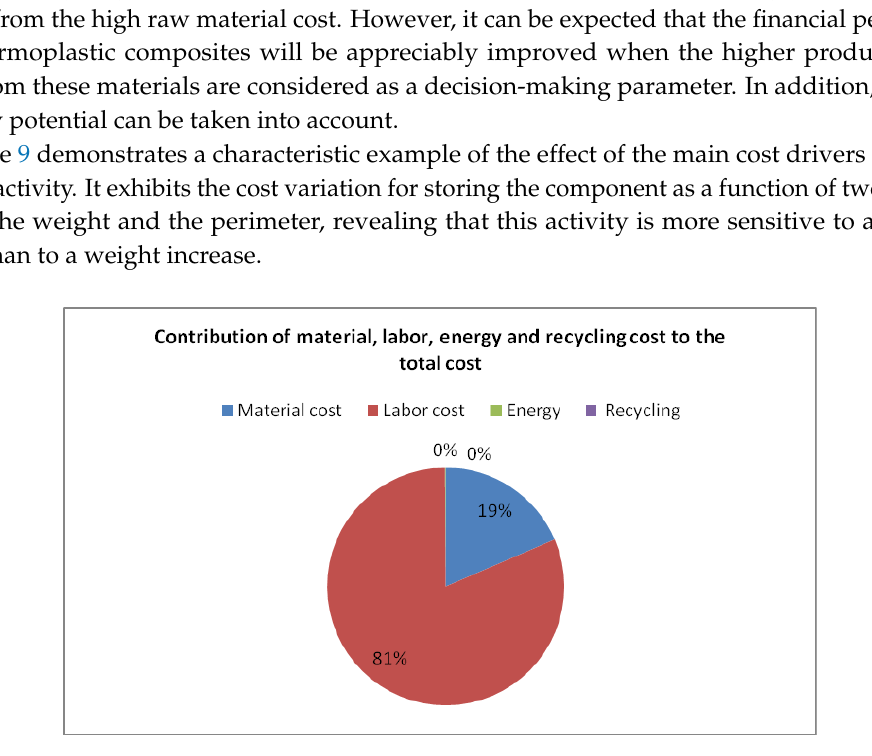
Figure 6. Contribution of the material, labor, energy and recycling cost to the total cost (autoclave-thermosetting composite).